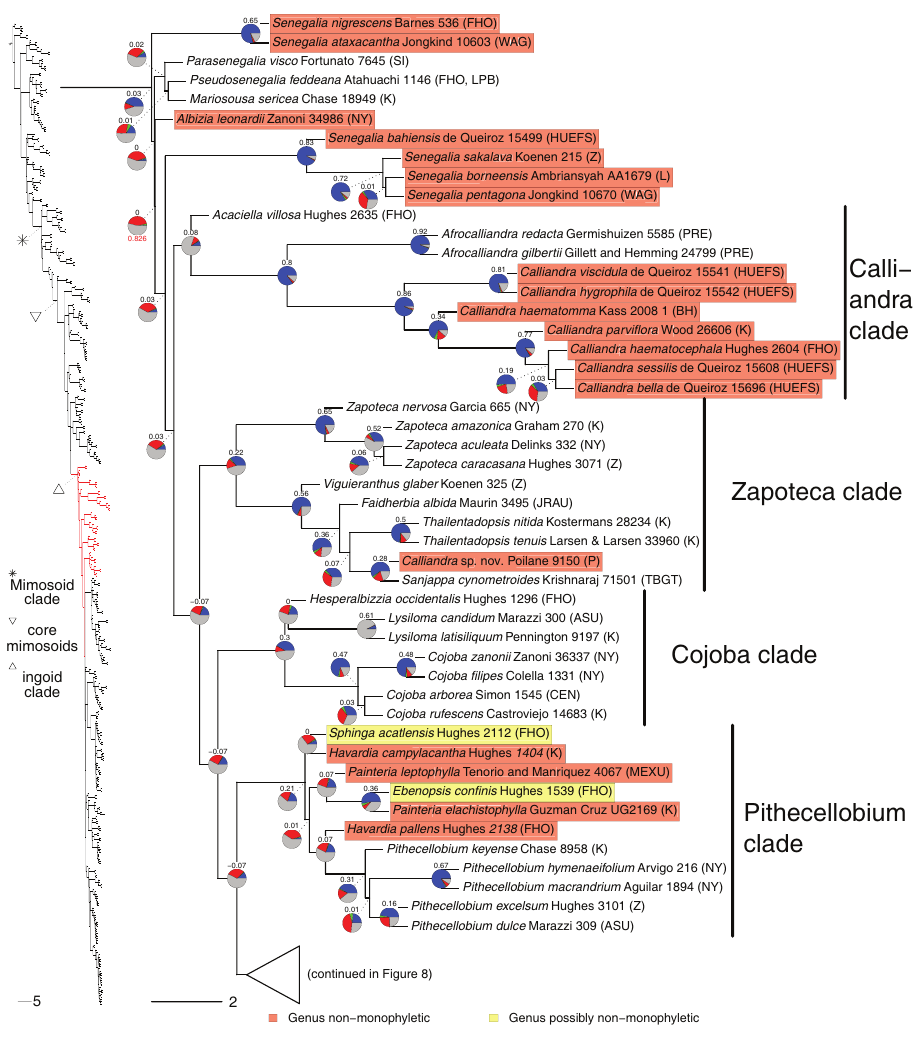
Figure 7. Phylogeny of Caesalpinioideae (continued). See Fig. 2 for